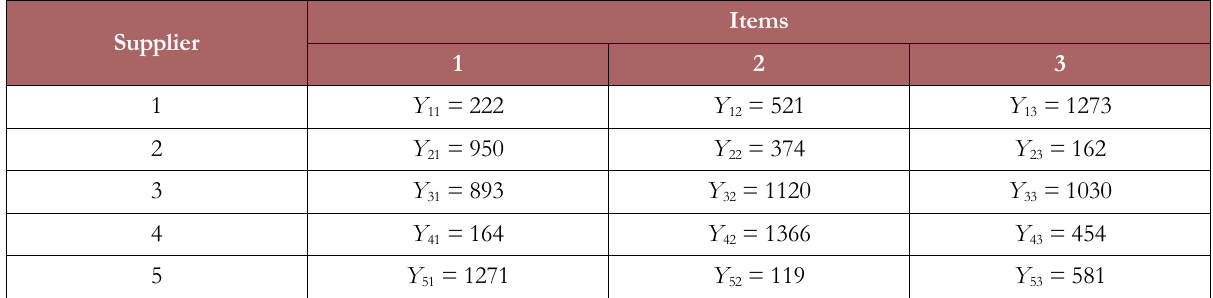
Table 4. The optimal solution of the case